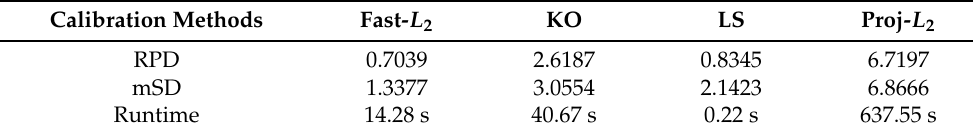
Table 2. Summary statistics of ˆ θ for different calibration